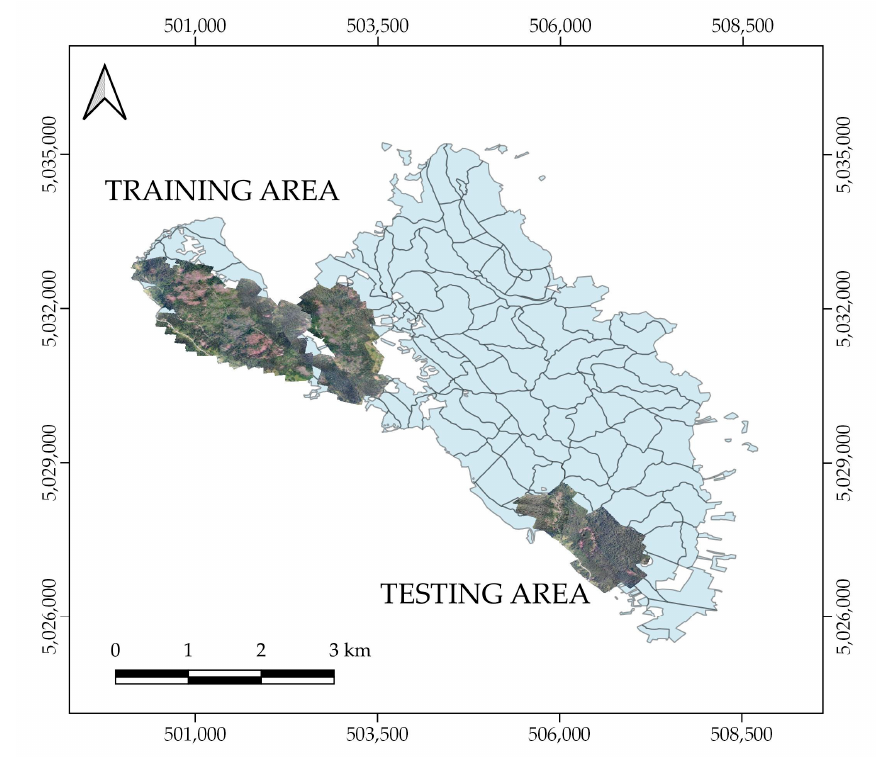
Figure 2. The locations of training and testing